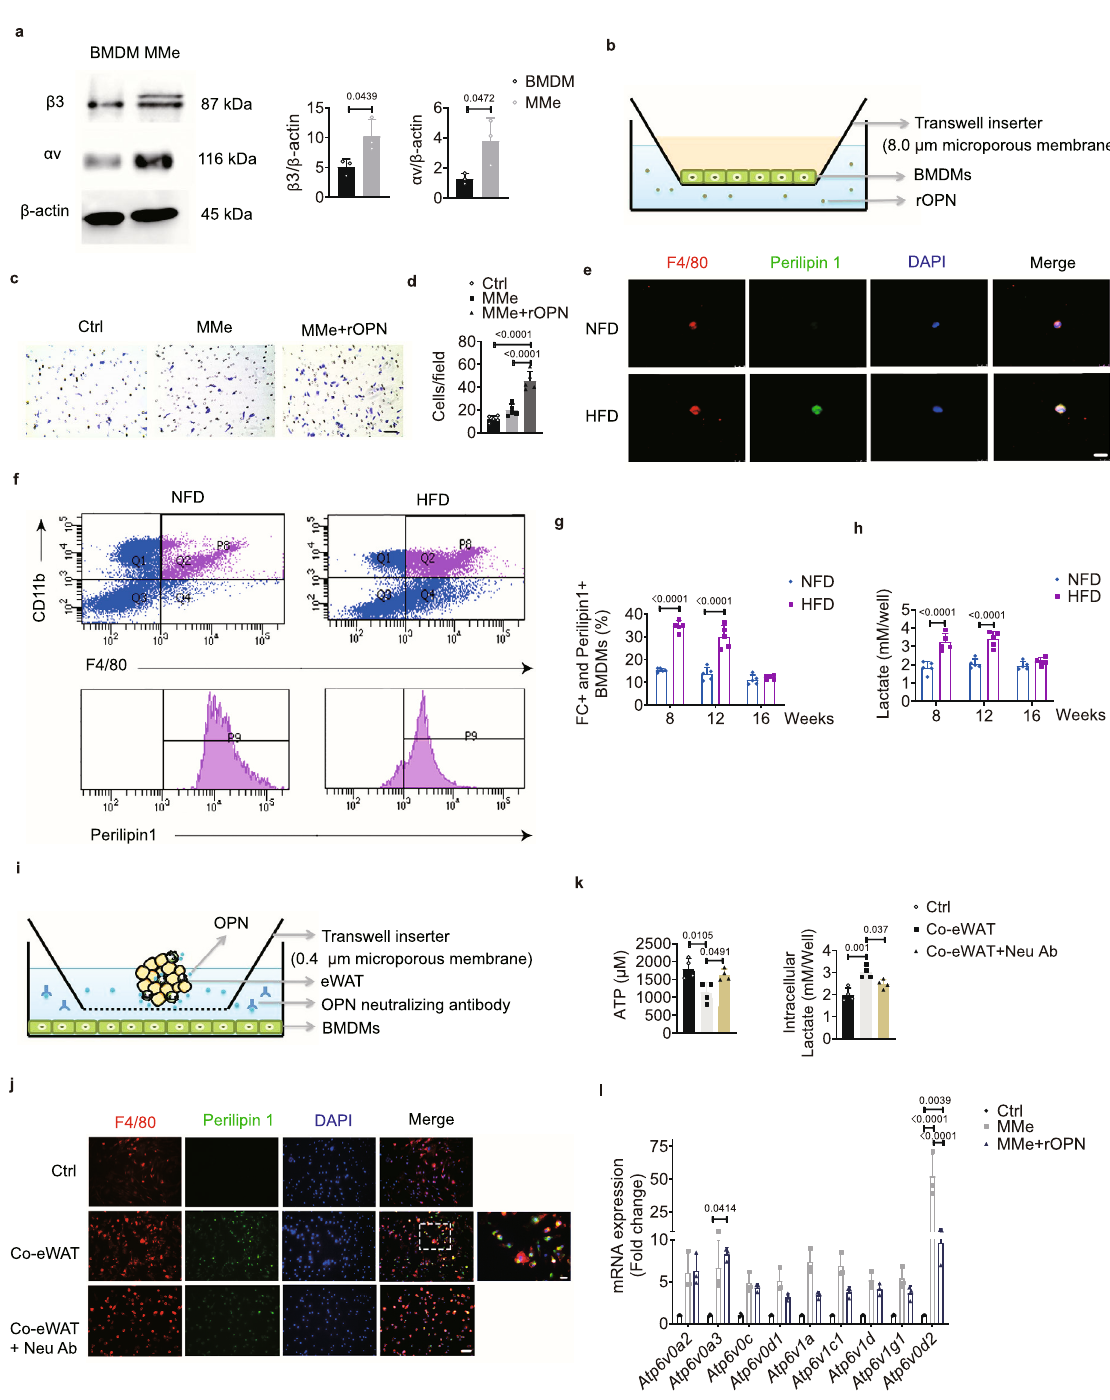
osteocytes, fi broblasts, dendritic cells, macrophages, hepatocytes, and endothelial cells, and acts systemically after secretion 38 . OPN